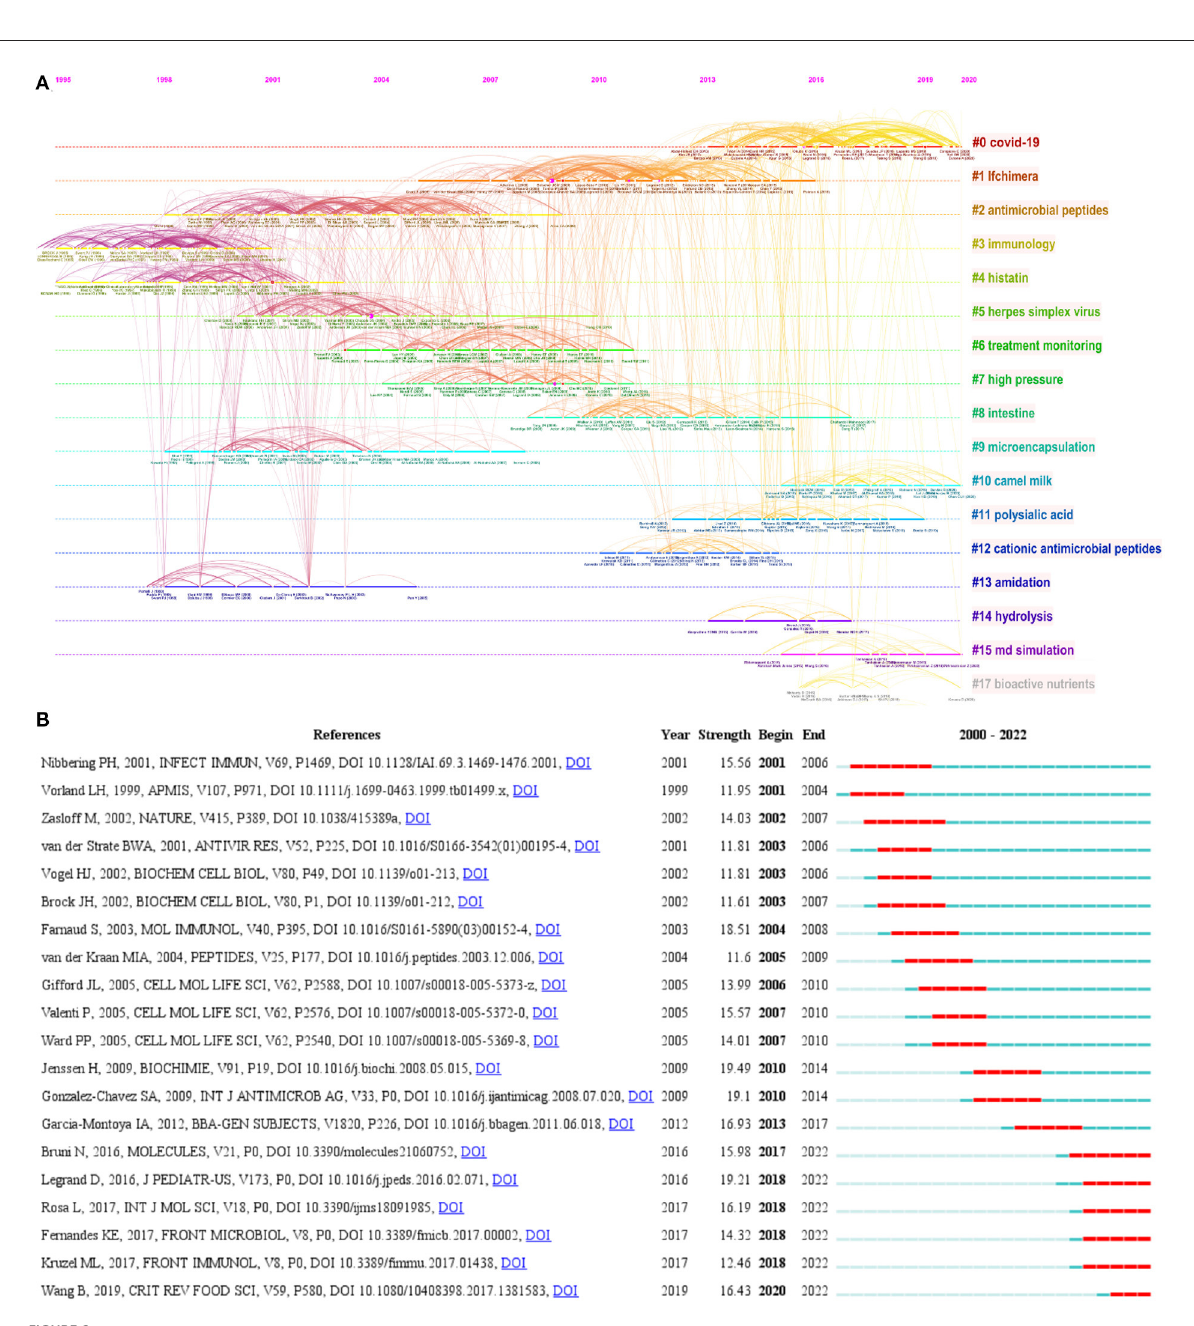
camel milk, polysialic acid, cationic antimicrobial peptides, amidation, hydrolysis, MD simulation